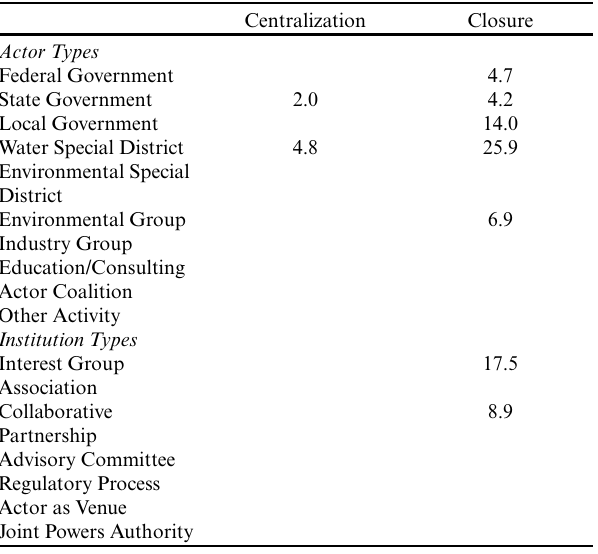
Table 3 . Residual analysis showing t statistics ≥